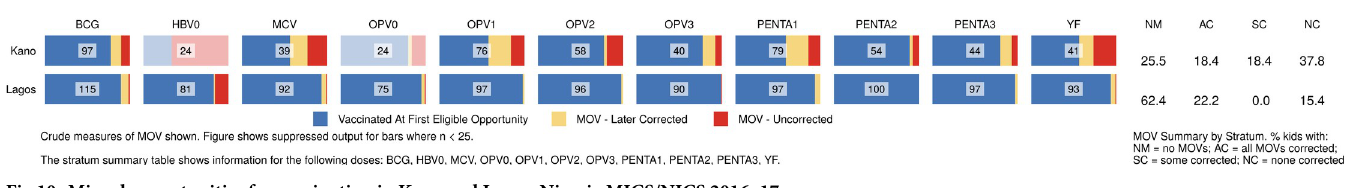
Fig 10. Missed opportunities for vaccination in Kano and Lagos, Nigeria MICS/NICS 2016–17.